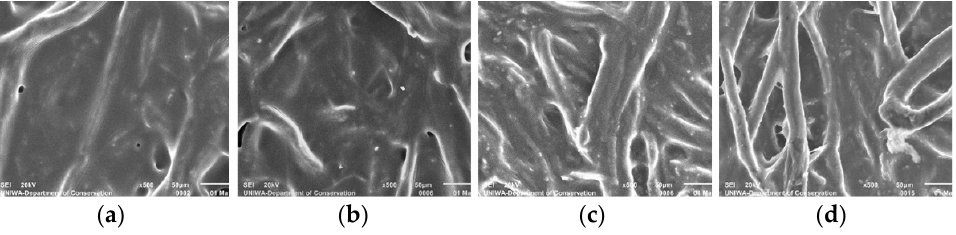
Figure 7. SEM images of cotton mock-ups impregnated with stand-oil at different stages of ageing, at 500× magnification: ( a ) 0 days of ageing, after 40 days of air-drying; ( b ) 7 days of ageing; ( c ) 14 days of ageing; ( d ) 21 days of ageing. 3.4. Mechanical Changes Thermal-humid ageing did not cause any notable changes to the tensile strength of plain paper mock-ups (C), while the impregnated mock-ups with all types of linseed oil presented a common trend of change with limited variations (Figure 8). The application of linseed oils on cotton paper caused a significant increase in tensile strength after 40 days of ageing (average 22%). The tensile strength of the mock-ups gradually decreased up to the fourth day of ageing, obtaining measurements close to those of the plain ones, while at the following stages, the fall was more intense. After 28 days of ageing, the tensile strength of the impregnated cotton mock-ups decreased up to 80% (Figure 8).